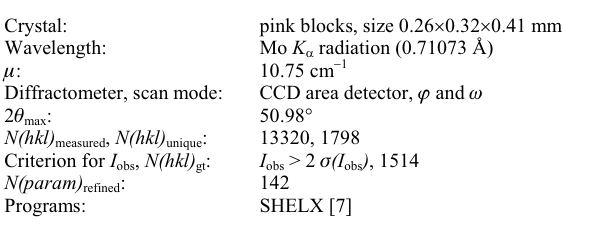
Table 1. Data collection and handling.